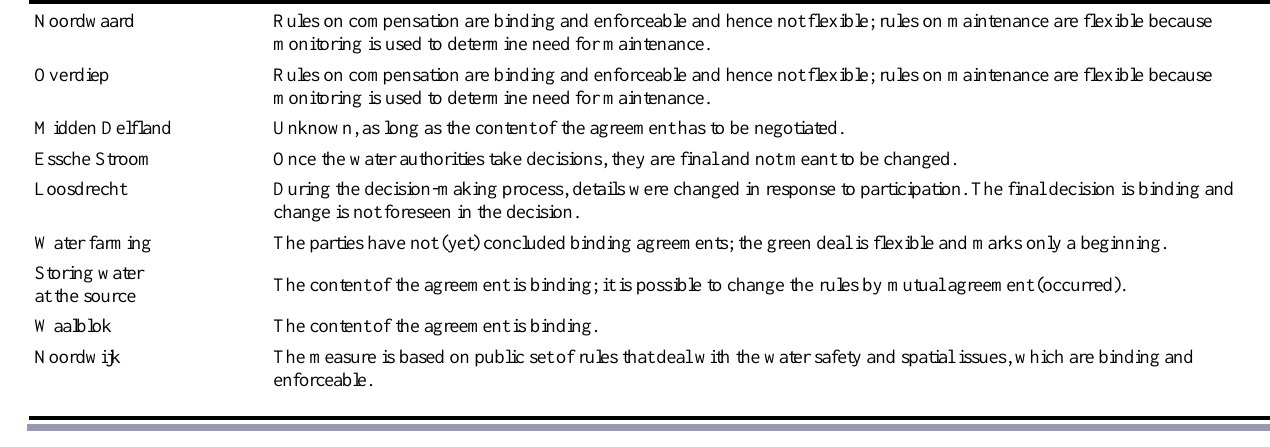
Table 8. Flexibility of the content from a legal perspective. Noordwaard